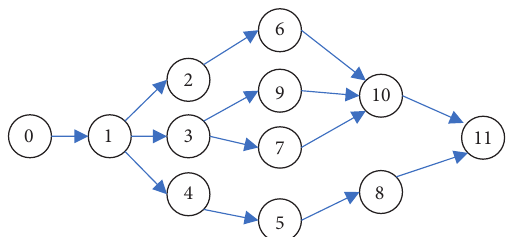
Figure 1: The relationship between